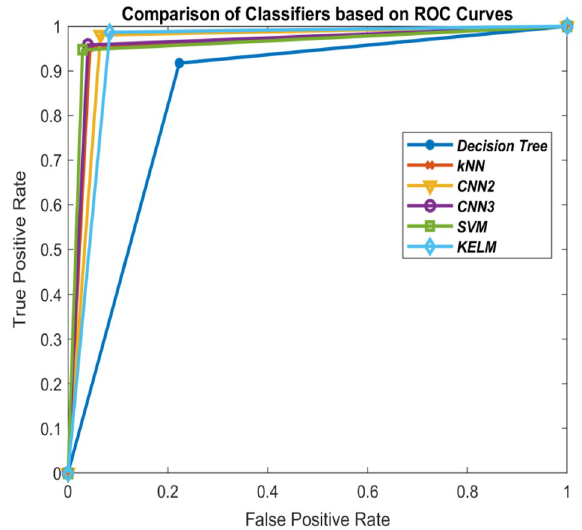
Figure 13. Comparison of the classifiers based on ROC curves (70–30 train-test ratio) of CoViD19+ve and CoViD19−ve.